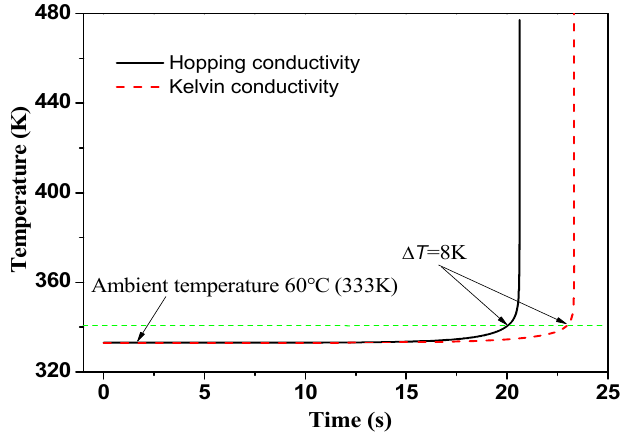
Figure 5. Comparison of thermal breakdown simulations and breakdown experiments.